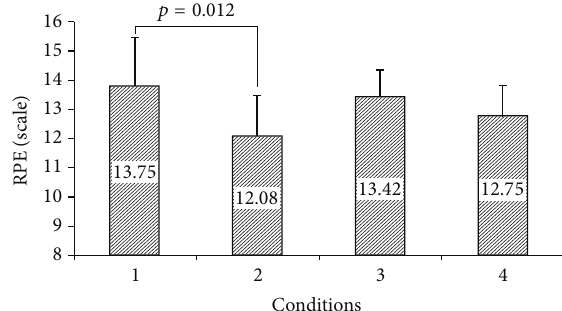
Figure 1: Rating of perceived exertion following 4 conditions; 1: WU+RE without M, 2: WU+RE with M, 3: WU with M+RE without M, and 4: WU without M+RE with M.